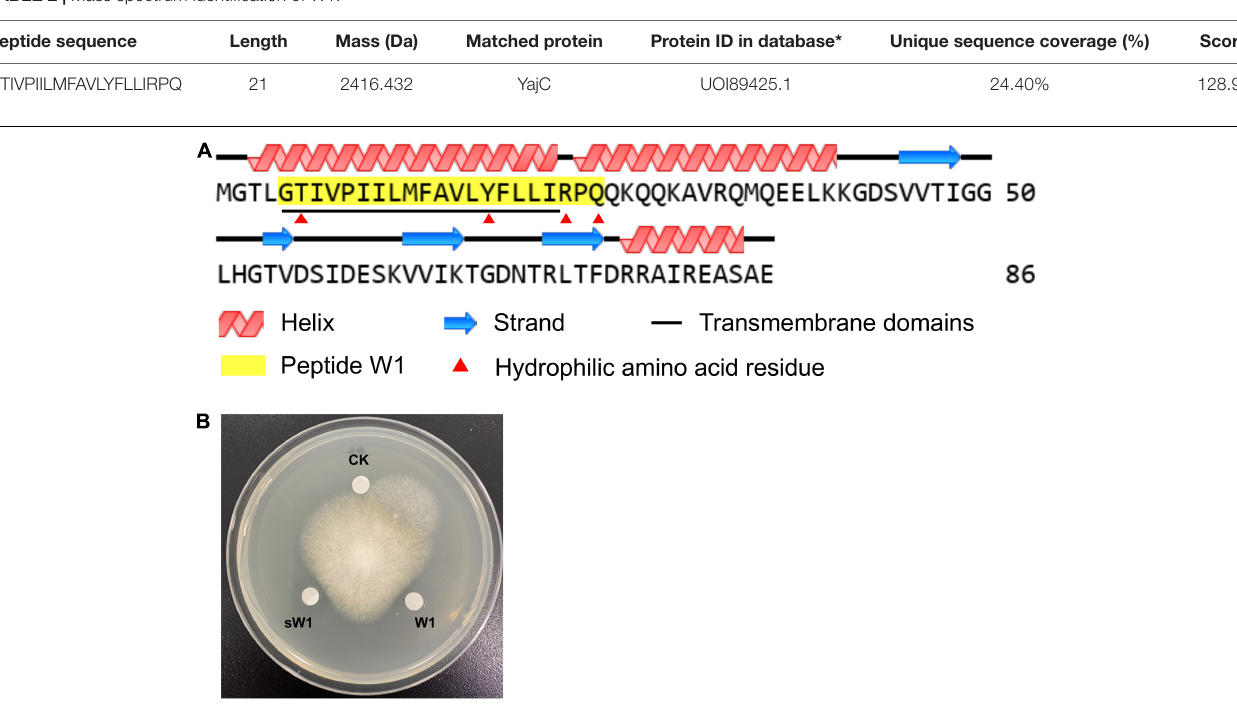
FIGURE 5 | The structure and antifungal activity of W1. (A) Protein structure analysis of YajC and W1. The GenBank database reference number of YajC was UOI89425.1. (B) The antifungal activity of purified peptide (W1) and synthesized peptide (sW1) against F. oxysporum .